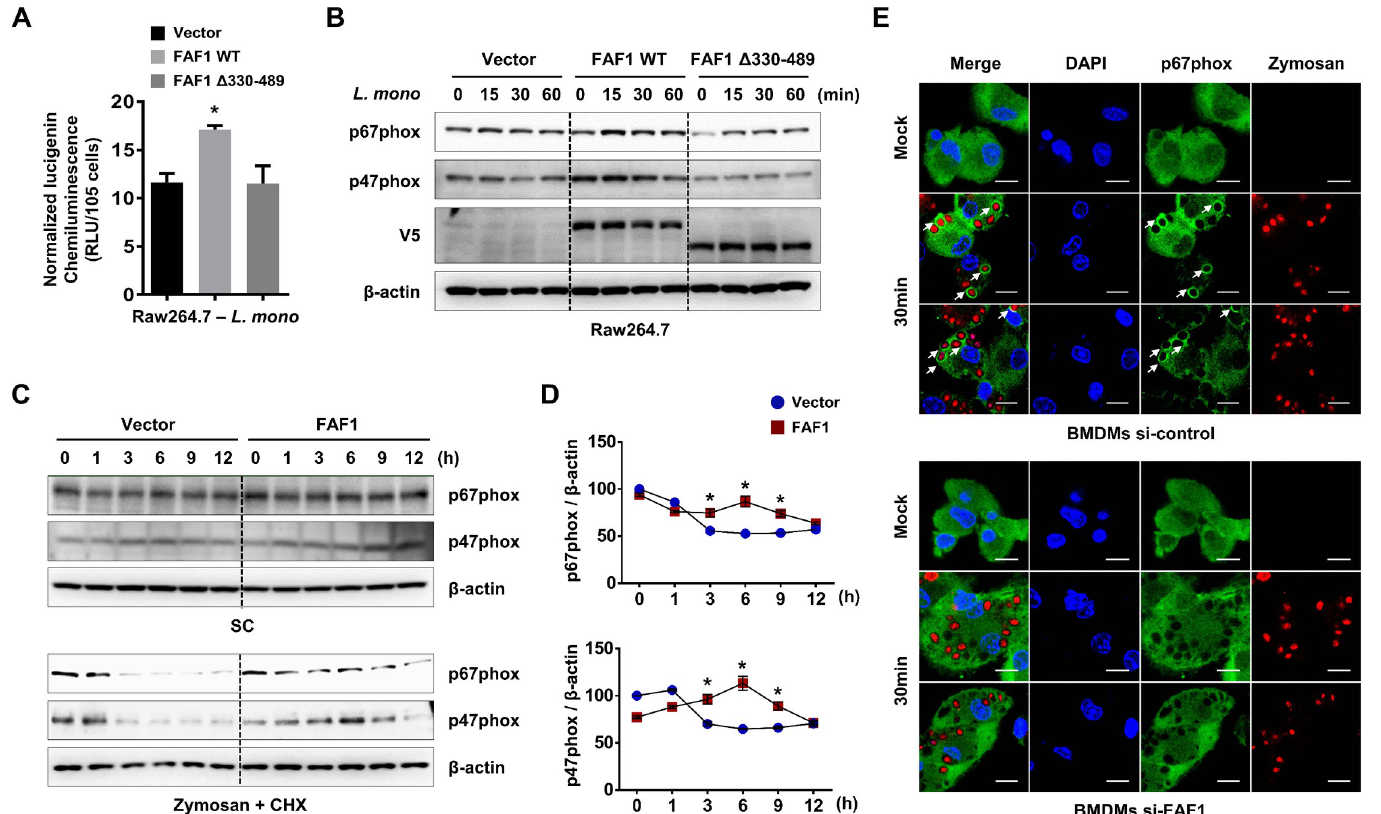
Fig 6. FAF1 promotes the stability of p67phox, leading to increased phagocytic NADPH oxidase activity against L . monocytogenes infection. (A) Raw264.7 cells containing empty vector or V5-tagged FAF1 wild-type or FAF1 Δ 330–489 were analyzed for NADPH oxidase activity upon L . monocytogenes infection (MOI = 1). (B) Raw264.7 cells containing empty vector or V5-tagged FAF1 wild-type or FAF1 Δ 330–489 were infected with L . monocytogenes for the indicated times, followed by immunoblotting with anti-p67phox, p47phox, V5 and β -actin antibodies. (C) Raw264.7 cells containing empty vector or V5-tagged FAF1 were treated with solvent control (SC, top) or zymosan / cycloheximide (CHX, 0.1 μ g/ml, bottom) for the indicated times and cell lysates were used for immunoblotting with anti-p67phox, p47phox and β - actin antibodies. (D) The relative expression levels of p67phox or p47phox were shown in graphs. (E) At 36hr post-transfection with siRNA-control or siRNA-FAF1, BMDMs were treated with pHrodo Red zymosan A bioparticles conjugates (0.5mg/ml) for 30min, followed by confocal microscopy with an anti-p67phox antibody. Scale bars represent 10 μ m. Data are representative of two (C) or three (A, B, E) independent experiments. Error bars, mean ± SD. � P < 0.05 (Student‘s t -test).